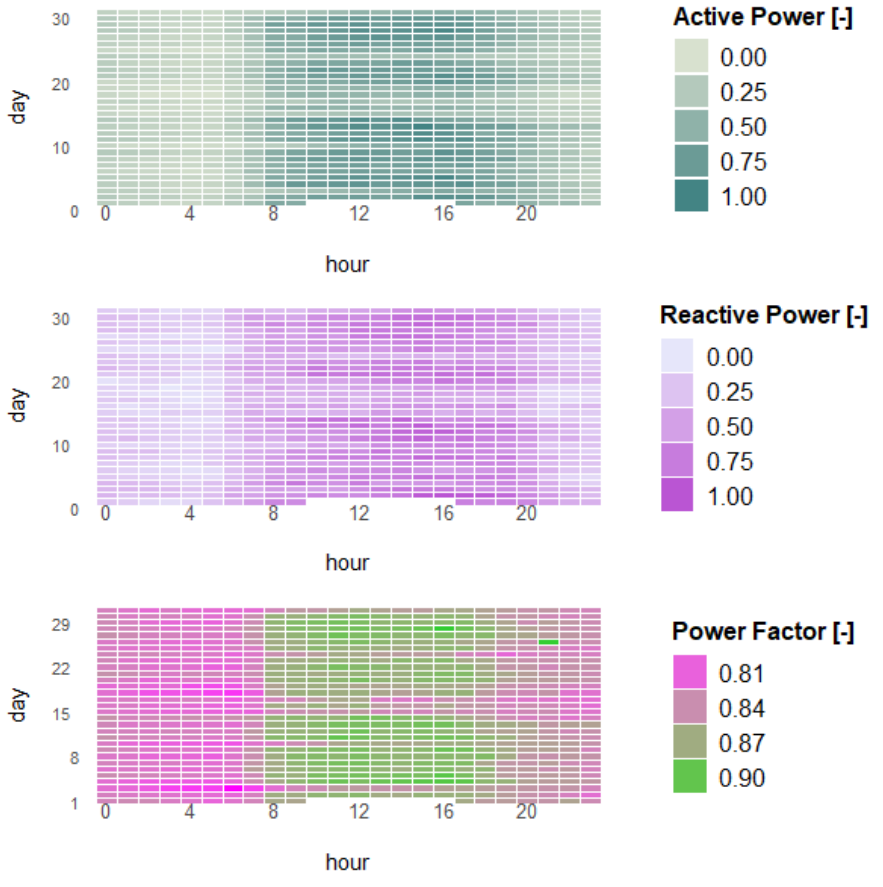
Figure 3. Visualization of the analyzed utility distinctive